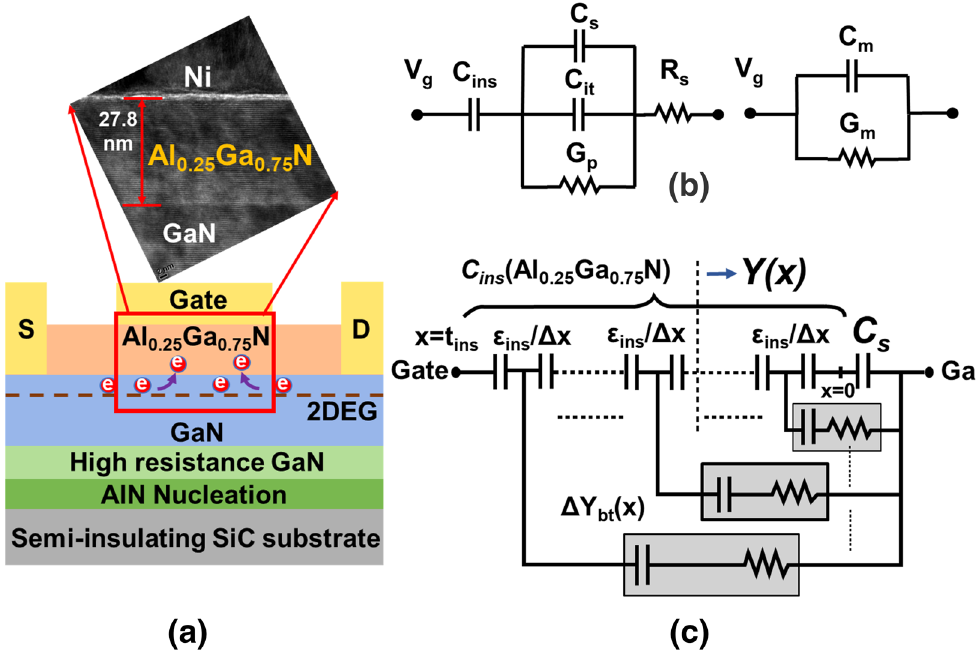
Figure 1. ( a ) Schematic cross-section and high-resolution TEM image of Al 0.25 Ga 0.75 N/GaN device. ( b ) Equivalent circuit diagram representing metal–insulator–semiconductor structure in depletion mode. ( c ) Equivalent circuit representing distributed bulk-oxide trap model 16,17